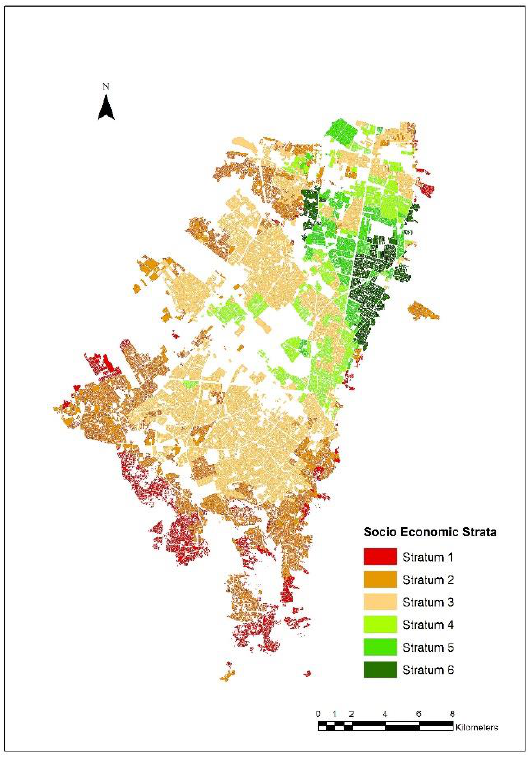
Figure 1. The socio-economic strata in the city of Bogotá, (based on [38]).